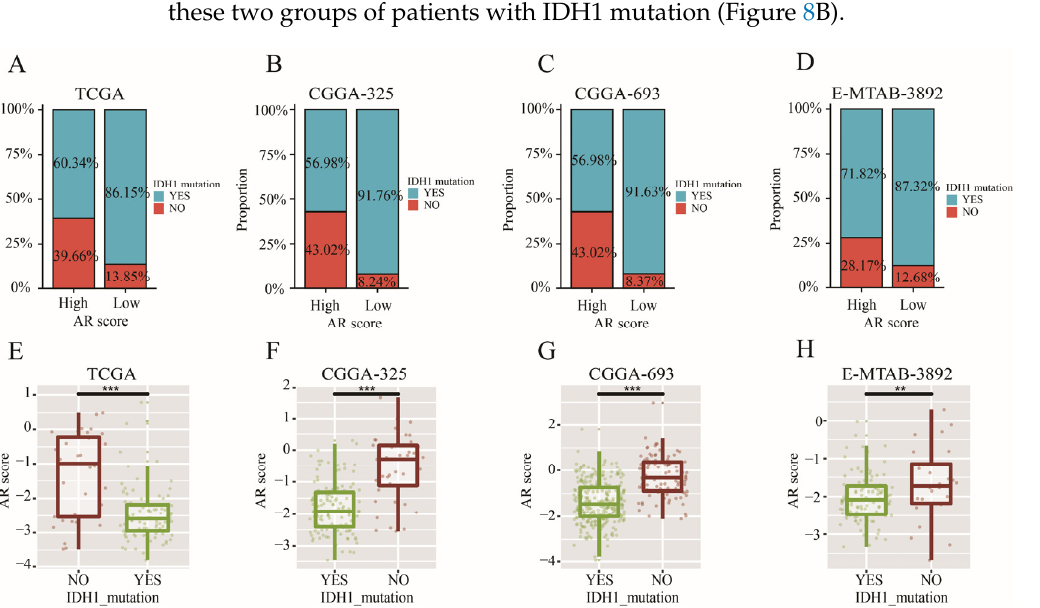
Figure 7. The relationship between AR-related signature and IDH1 mutation. ( A – D ) The ratio of IDH1 mutation between high- and low-AR groups in TCGA, CGGA-325, CGGA-693, and E-MATB- 3892, respectively. ( E – H ) The comparisons of AR scores between mutated IDH1 and wild-type IDH1 in TCGA, CGGA-325, CGGA-693, and E-MATB-3892, respectively. Data in ( E – H ) were analyzed by Wilcoxon test; ** p < 0.01, and *** p < 0.001.